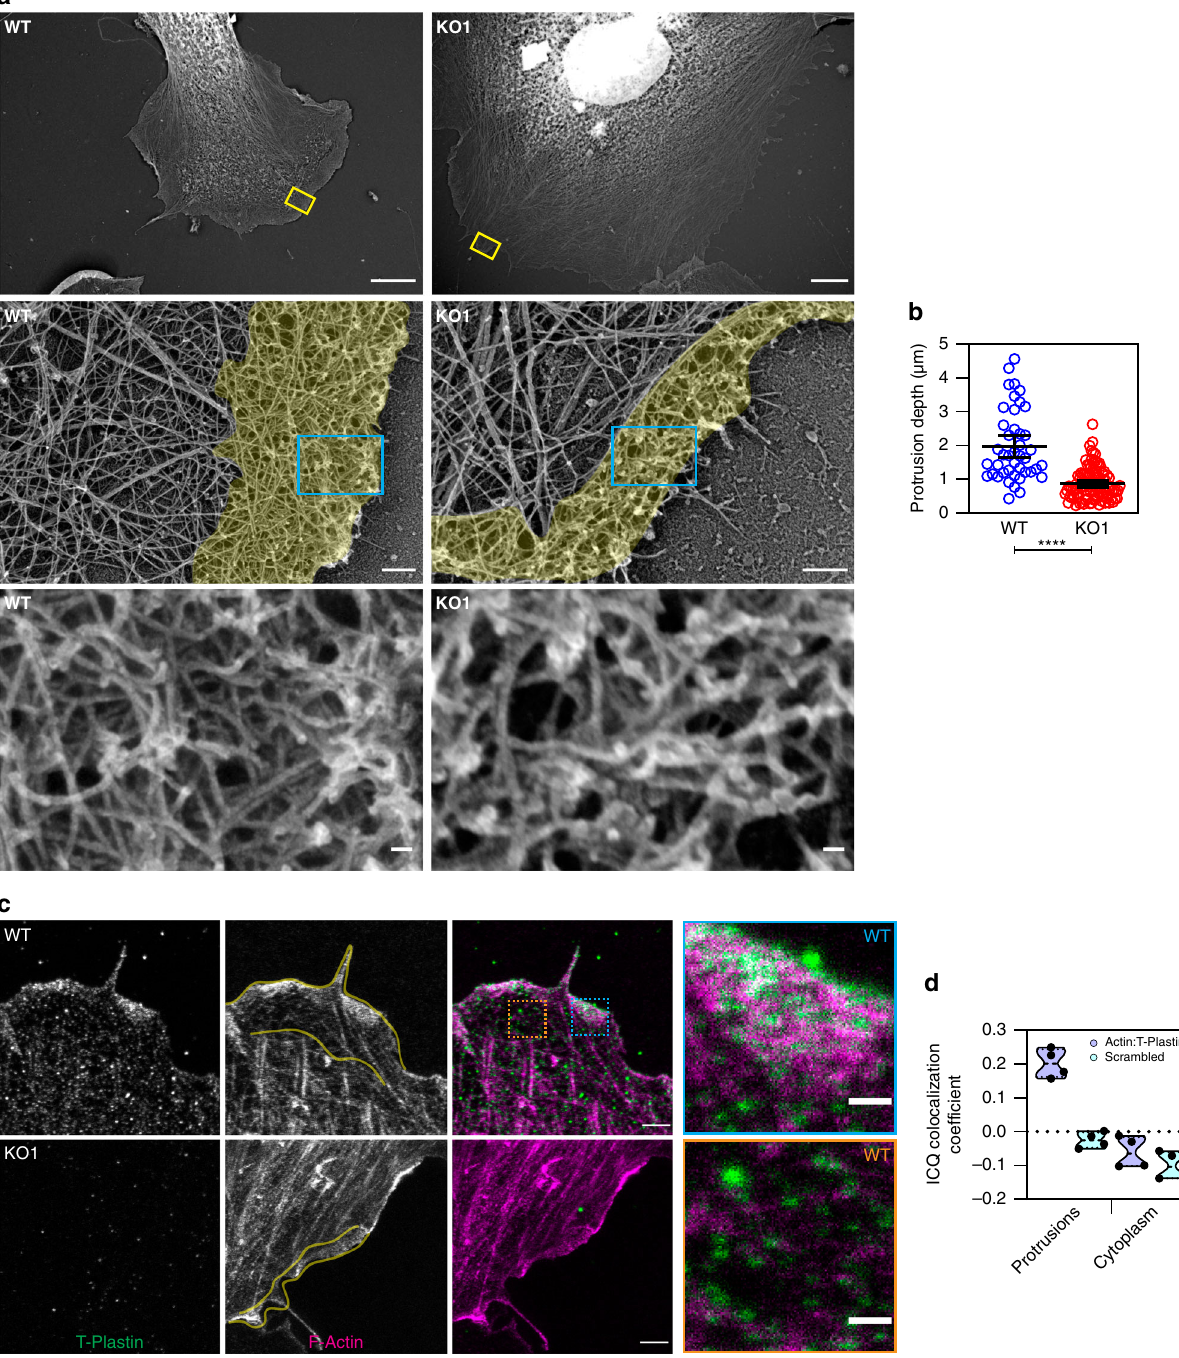
Fig. 7 Ultrastructural analysis showing that T-Plastin localizes to and strengthens protrusive actin structures. a PREM images of WT and T-Plastin KO1 HUVEC protrusions. Top, low magni fi cation images of cell protrusions, regions in yellow boxes correspond to magni fi ed regions shown in middle. Bars, 5 µ m. Middle, magni fi ed areas from top showing the leading edge. Cyan boxes correspond to the further magni fi ed regions shown in bottom. The depth of the branched protrusive network is highlighted in yellow. Bars, 200 nm. Bottom, Highly magni fi ed areas from middle showing the arrangement of actin fi laments at the very leading edge. Bars, 25 nm. b Quanti fi cation of protrusion depth, the distance the branched actin network persists from the leading edge of protrusions. Black bars represent the mean and 95% con fi dence intervals, analyzed using unpaired t-test, **** P < 0.0001 ( n protrusions WT = 43, KO = 100; taken from ≥ 3 independent replicates). c STED super-resolution images of WT and KO1 HUVEC stained for T-Plastin (green) and F-actin (magenta). Regions of high and low actin density in a WT protrusion are magni fi ed in orange and cyan boxes as indicated. Bars 2 µ m and 500 nm, respectively. Yellow lines indicate extent of the protrusion. d Violin plot of intensity correlation quotients between T-Plastin and F-actin (purple), quanti fi ed in protrusion and cytoplasmic regions (see Fig. S8b, for example). As a control (cyan) the values for F-actin were scrambled. Black dots indicate individual values for different images ( n cells = 4, representative of three independent replicates), medians are shown as black dotted line within colored